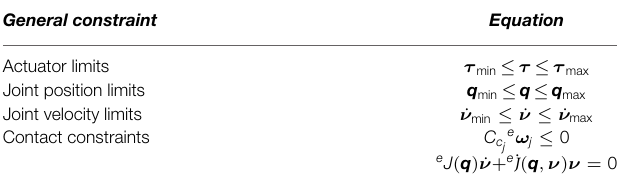
TABLE 3 | Possible constraints in